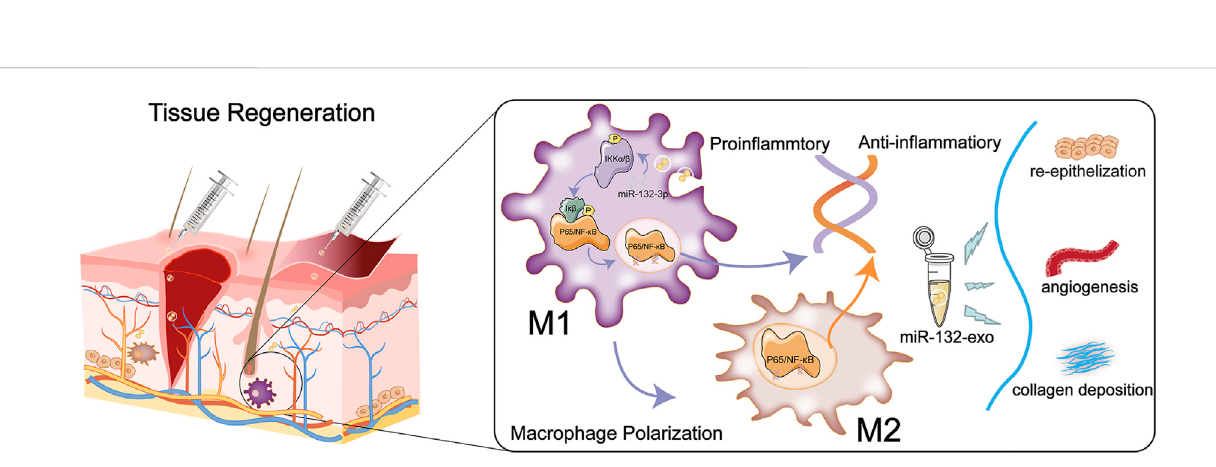
Frontiers in Bioengineering and